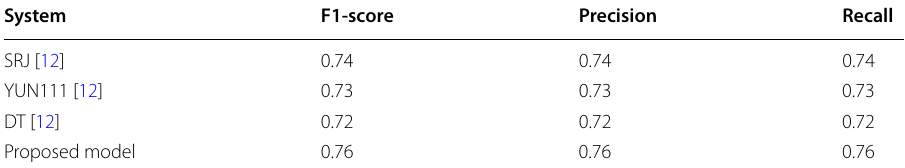
Table 10 Validation of the proposed work with the published results in FIRE 2020 for SA System